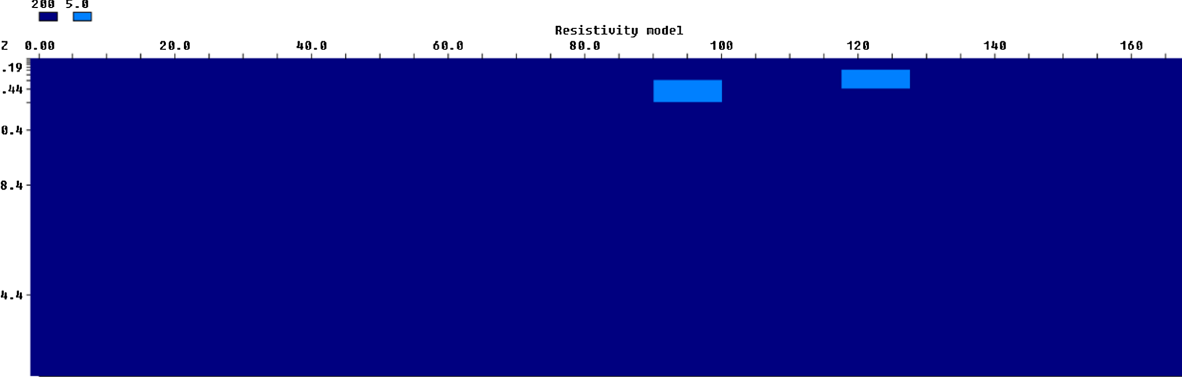
Fig. 1 Synthetic model of two layers, layer with 200 Ω m represent alluvium sediments, while layer with 5 Ω m represents salt